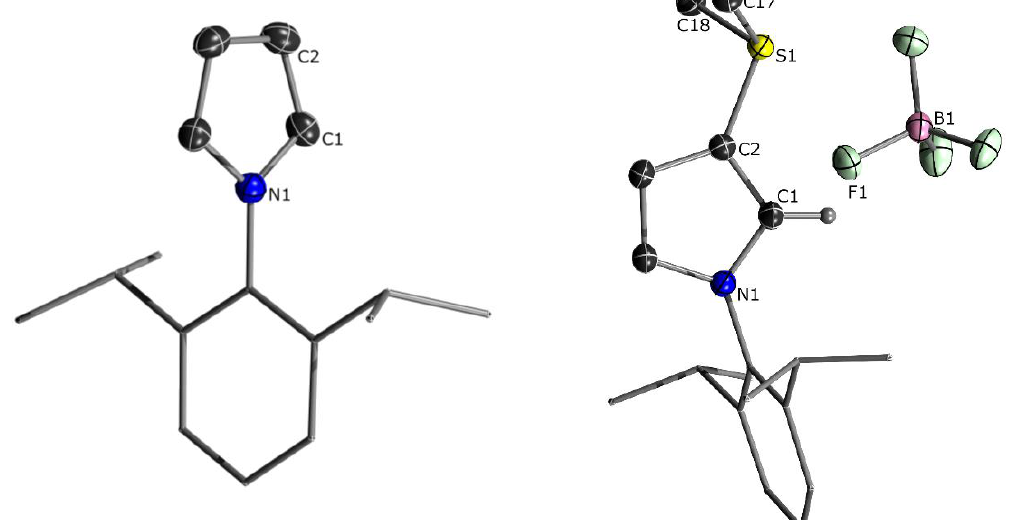
Figure 3. Molecular structure of N -(2,6-diisopropylphenyl)pyrrole (left) and 9 . Ellipsoids are drawn at the 50% probability level. Selected bond lengths (Å) and angles ( ◦ ): N-(1,2-Diisopropylphenyl)pyrrole: